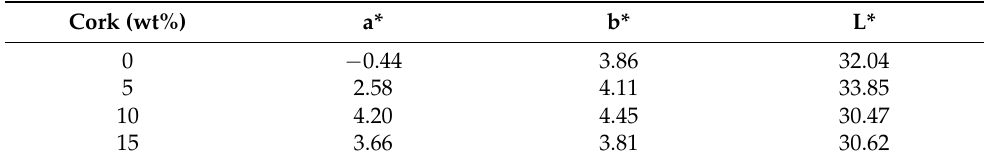
Table 4. Colorimetry test results for